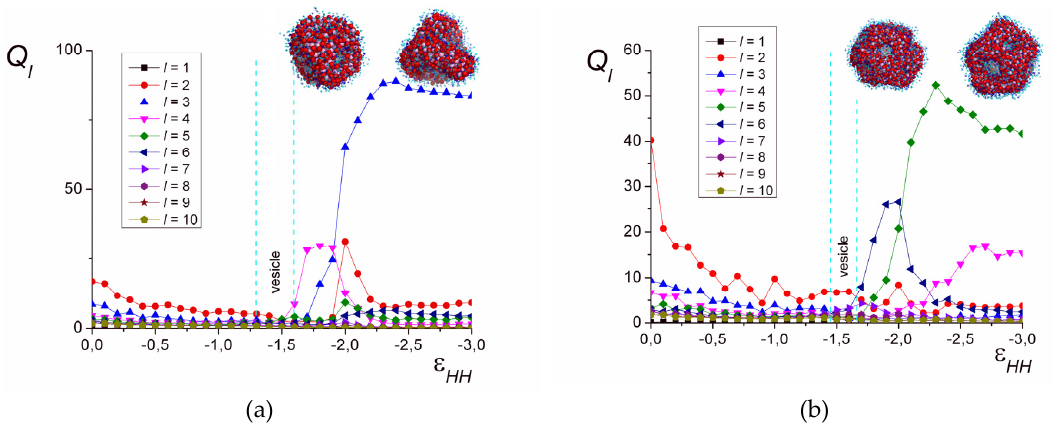
Figure 6. The order parameter Q l depending on ε HH . l B = 4, N = 1024 ( a ), N = 2048 ( b ). Morphological diagrams in coordinates “solvent quality vs. Bjerrum length” ( N = 1024)